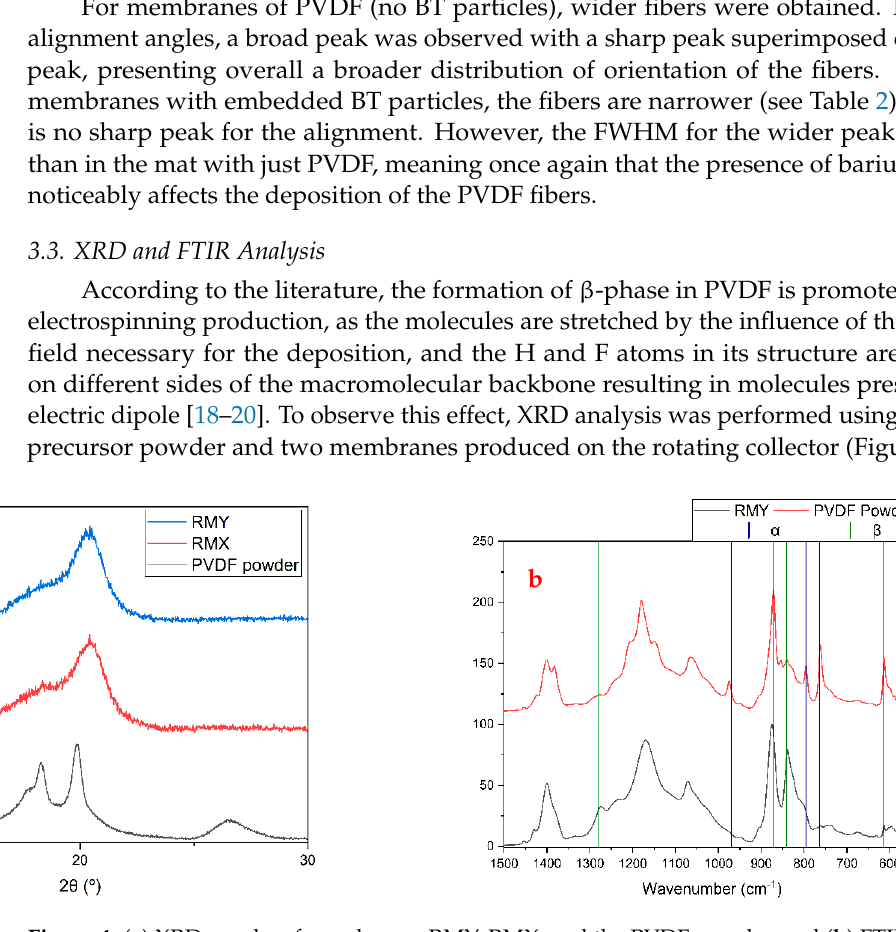
Figure 4. ( a ) XRD graphs of membranes RMY, RMX, and the PVDF powder, and ( b ) FTIR spectra of membrane RMY and PVDF powder overlayed with peak values from the α and β phases.